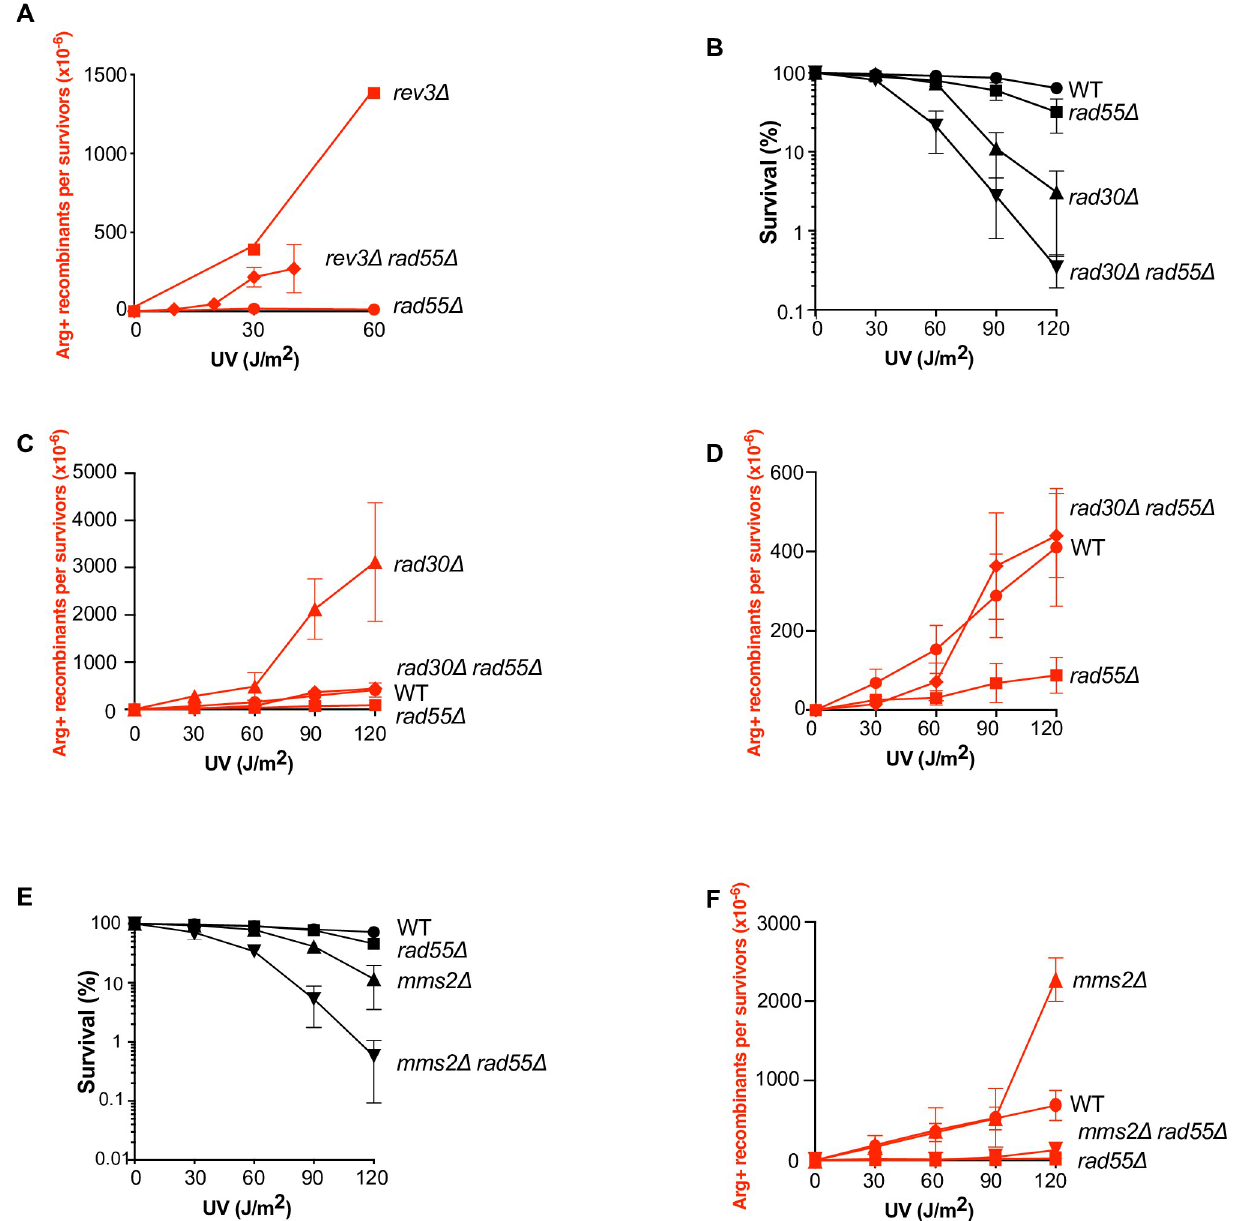
Fig 4. RAD55 -independent UV-induced HR in TLS-deficient cells. (A) UV-induced [Arg+] recombinant frequencies in rad55 Δ rev3 Δ diploid cells. The very strong UV sensitivity displayed by the double mutant precluded the quantification of the UV-induced recombinant rate at UV doses higher than 40J/m 2 . (B) Survival of rad55 Δ rad30 Δ diploid cells following UV radiation. (C) UV-induced [Arg+] recombinant frequencies in rad55 Δ and rad30 Δ diploids cells. (D) Close-up view of (C) to exclude the hyper-recombinogenic phenotype of rad30 Δ . (E) Rad55 Δ mms2 Δ diploid cell-survival upon UV radiation. (F) UV-induced [Arg+] recombinant frequencies in rad55 Δ and mms2 Δ diploid cells.